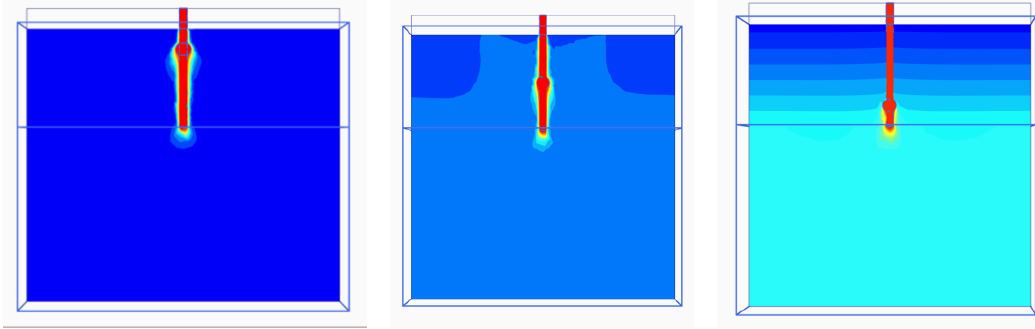
Figure 6: Deformation sketch of single bulb of under-reamed piles under axial